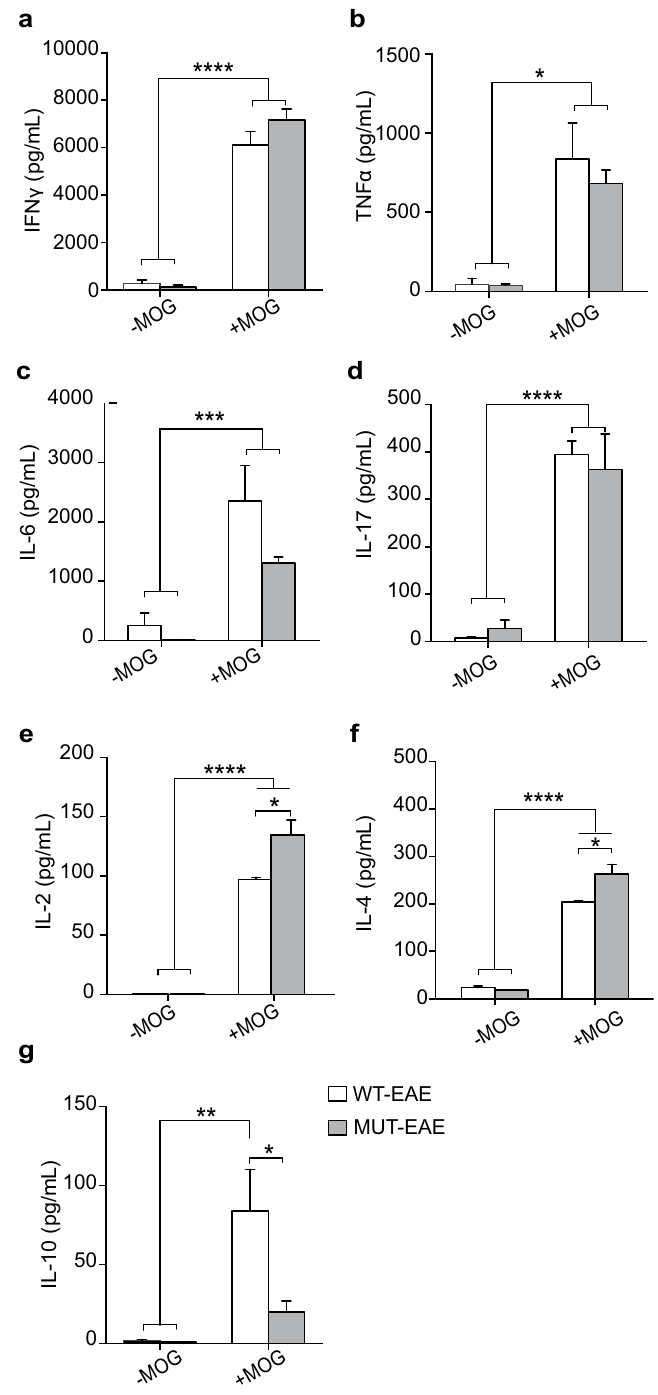
Figure 2. MOG-induced cytokine production during acute stage of EAE. Cytokines levels in supernatants from splenocytes isolated from WT-EAE and MUT-EAE animals was assessed in the absence or presence of MOG for 72 h using a cytometry kit (− MOG, + MOG, respectively). For all cytokines analyzed: ( a ) IFNγ, ( b ) TNFα, ( c ) IL-6, ( d ) IL-17, ( e ) IL-2, ( f ) IL-4, ( g ) IL-10, in vitro re-stimulation with MOG induced a significant increase in cytokine secretion in both WT and MUT groups, compared to the absence of MOG in culture (− MOG). ( e,f ) IL-2 and IL-4 levels secreted by MUT-EAE + MOG splenocytes were higher compared to WT-EAE + MOG, while IL-10 was only increased in WT-EAE ( g ). All values are presented as media ± SEM. Two-way ANOVA and Tukey post hoc test performed. *p < 0.05; **p < 0.002; ***p < 0.0002; ****p < 0.0001. WT-EAE n = 4; MUT-EAE n =